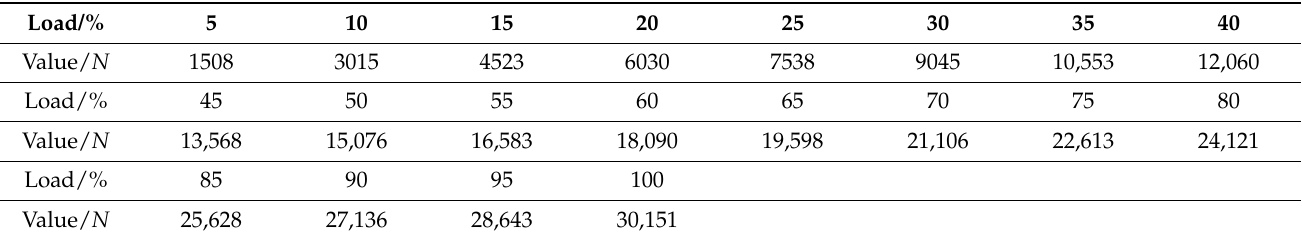
Figure 7. ( a )The position of the test strain flower ( b )strength test equipment. Figure 7. ( a ) The position of the test strain flower ( b ) strength test equipment. In the aspect of load loading, 5% of the test load is taken as the first level, and the load is coordinated to 100% of the test load step by step. Load is maintained for 30 s, as shown in Table 3. The load loading process is then unloaded step by step to no load. During the test, as the load is gradually loaded, the test piece, as a whole, produces a small displacement deformation in the loading direction. In the process of step-by-step unloading of the load, the displacement deformation generated by the test piece disappears, and no obvious cracks or damage occur during the whole process. Finally, the strain curve under the test load is shown in Figure 8. The maximum test strain is 1577.9 µε at the position of the strain sensor S6, and the strain values at the positions of the remaining strain sensors, S1 to S5, are 344.5 µε , 676.4 µε , 726.7 µε , 1378.1 µε , and 1199.9 µε , respectively. It shows that the strain situation of the area of the test piece gradually increased from left to right, and it relates to the thickness distribution of the test piece, where thickness on the left is greater than the thickness on the right. Table 3. The load loading